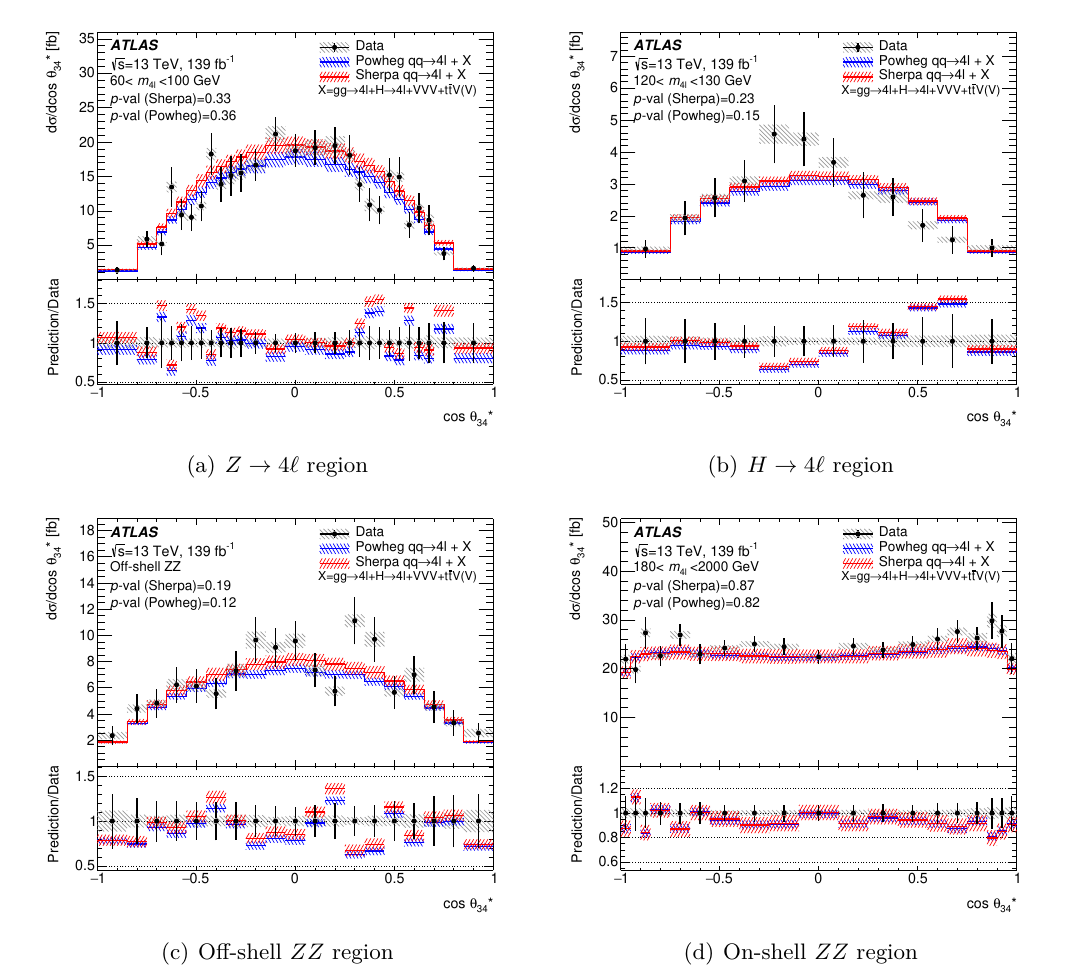
in the four m regions. The measured Figure 11 . Differential cross-sections as a function of cos θ ∗ 4 ‘ 34 data (black points) are compared with the SM prediction using either Sherpa (red, with red hashed band for the uncertainty) or Powheg + Pythia8 (blue, with blue hashed band for the uncertainty) to model the q ¯ q → 4 ‘ contribution. The error bars on the data points give the total uncertainty and the grey hashed band gives the systematic uncertainty. The p -value is the probability for the χ 2 , with the number of degrees of freedom equal to the number of bins in the distribution, to have at least the observed value, given the SM prediction. The lower panel shows the ratio of the SM predictions to the